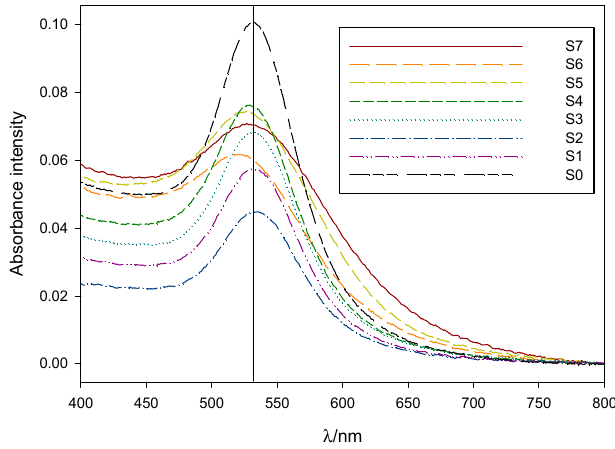
Figure 2. Normalized absorbance spectra, taken between 24 h and 96 h after synthesis, for 1:10 dilutions of samples S7 to S1 and S0. Vertical line marks the position for the absorption maxima of sample S0 at 531 nm.